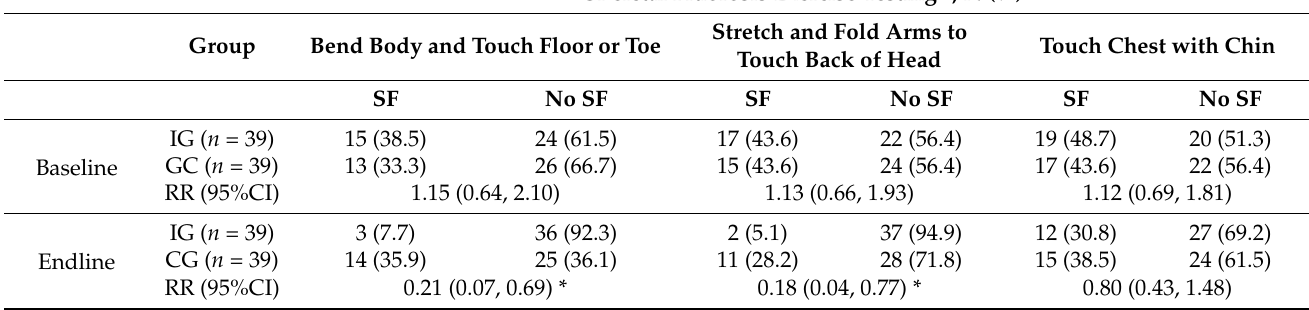
Table 4. Skeletal fluorosis (SF) exercise testing in a 6-month eggshell powder intervention between intervention and control groups in Halaba district, Ethiopian Rift Valley,